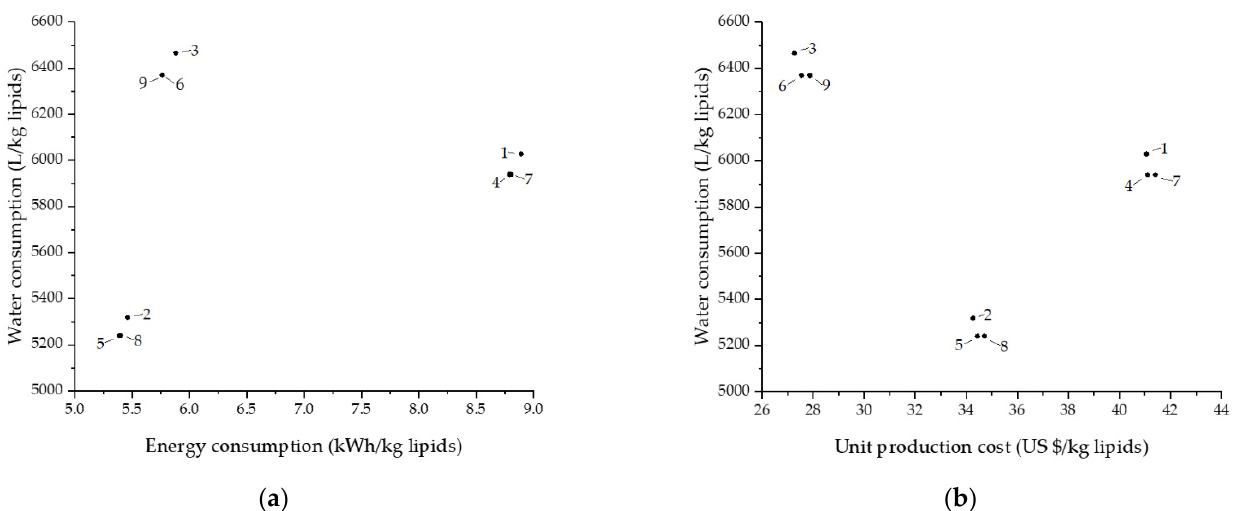
Figure 12. Water consumption in the scenarios analyzed for the production of lipids: ( a ) Energy consumption vs. water consumption; ( b ) unit production cost vs. water consumption.